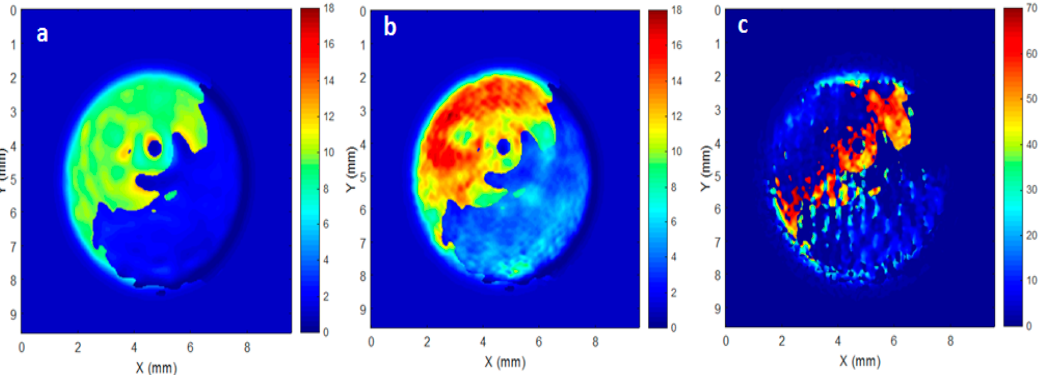
Figure 5. THz-TDS-based CCD imaging results at 200 GHz: ( a , b ) printed silver on a Teslin paper substrate without rolling treatment; ( c,d ): printed silver on a Teslin paper substrate with rolling treatment; ( e,f ) printed silver ink electrodes on a thin polyethylene film substrate. The left plots are the absorption rate (cm − 1 ) and the right plots are the phase angle ( 𝜋,−𝜋) .